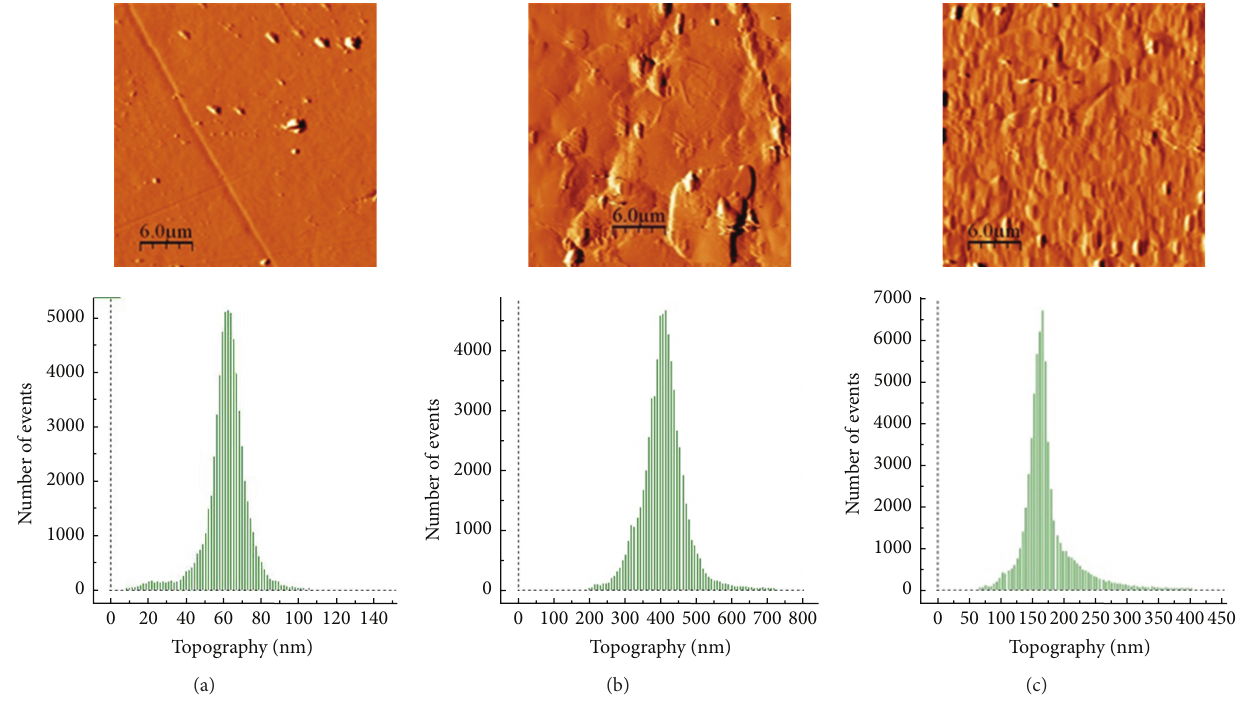
Figure 2: AFM images of the surface of polymer composites: (a) the source of LDPE, (b) 90 wt.% LDPE/10wt.% PA-6, (c) 90wt.% LDPE/10wt.% PA-6/1wt.% EVA type I/0.1wt.% Agidol-40/0.1 wt.% Irgafos-168.